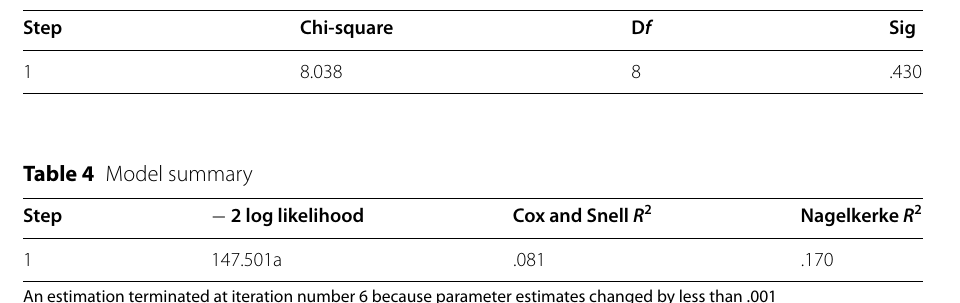
Table 3 Hosmer–Lemeshow